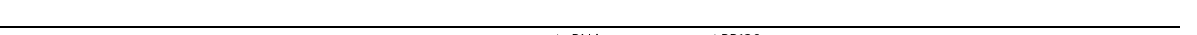
Fig. 7 PR130 modulates cell cycle control during replicative stress. a HCT116 Δ gRNA and HCT116 Δ PR130 (clone #3) cells were treated with 2 µ M MS-275 and/or 1 mM hydroxyurea (HU) for 24 h. Indicated proteins and their phosphorylation were analysed by western blot; β -Actin served as loading control. b Densitometric analysis of CHK1 phosphorylation (S317) and total CHK1 levels after 24 h following protein detection via western blot. Data were normalised to the respective loading controls. The amount of (phosphorylated) proteins was normalised to that of HU-treated cells. Results represent the mean ± SD ( n = 8; two-way ANOVA, **** P < 0.0001). c HCT116 Δ gRNA (left panel) and HCT116 Δ PR130 (clone #3; right panel) cells were treated with 1 mM HU and 2 – 5 µ M MS-275 for 28 h. Cells were stained with PI and analysed using fl ow cytometry. Data are mean ± SD ( n = 3). d Cells were incubated as stated in a . Immunoblots were carried out for WEE1, pHDAC2, pCDK1 and HSP90 as loading control. Numbers indicate densitometric analysis of western blot signals relative to untreated HCT116 Δ gRNA cells and normalised to HSP90 ( n = 3). e Western blot analysis of p21 and β -actin (loading control). Signals of p21 are displayed relative to untreated controls and normalised to β -actin. f Increasing doses of 1 – 5 mM HU stall the cell cycle of HCT116 cells more pronouncedly in early G1/S phase. HU was applied for 24 h ( n = 3). g HU (1 – 5 mM) was applied to HCT116 cells for 24h. Western blot was done as indicated.